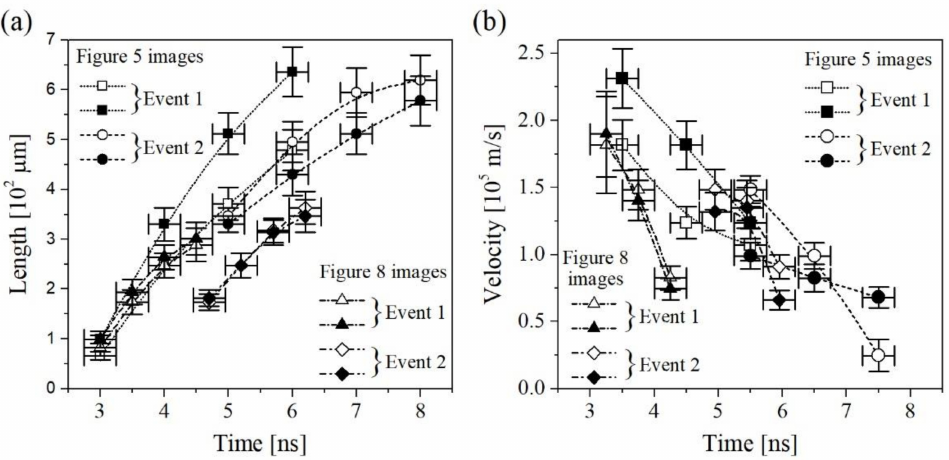
Figure 14. Length ( a ) and expansion velocity ( b ) of the fronts of the primary luminous filaments. Length obtained as a geometrical distance of the luminous front from the root of the filament at the anode tip. Expansion velocity obtained from geometrical distance of two captured luminous fronts and the time interval between the closing edges of the corresponding MCP gates. Evaluated from the Event 1 and 2 image sequences shown in Figure 5; Figure